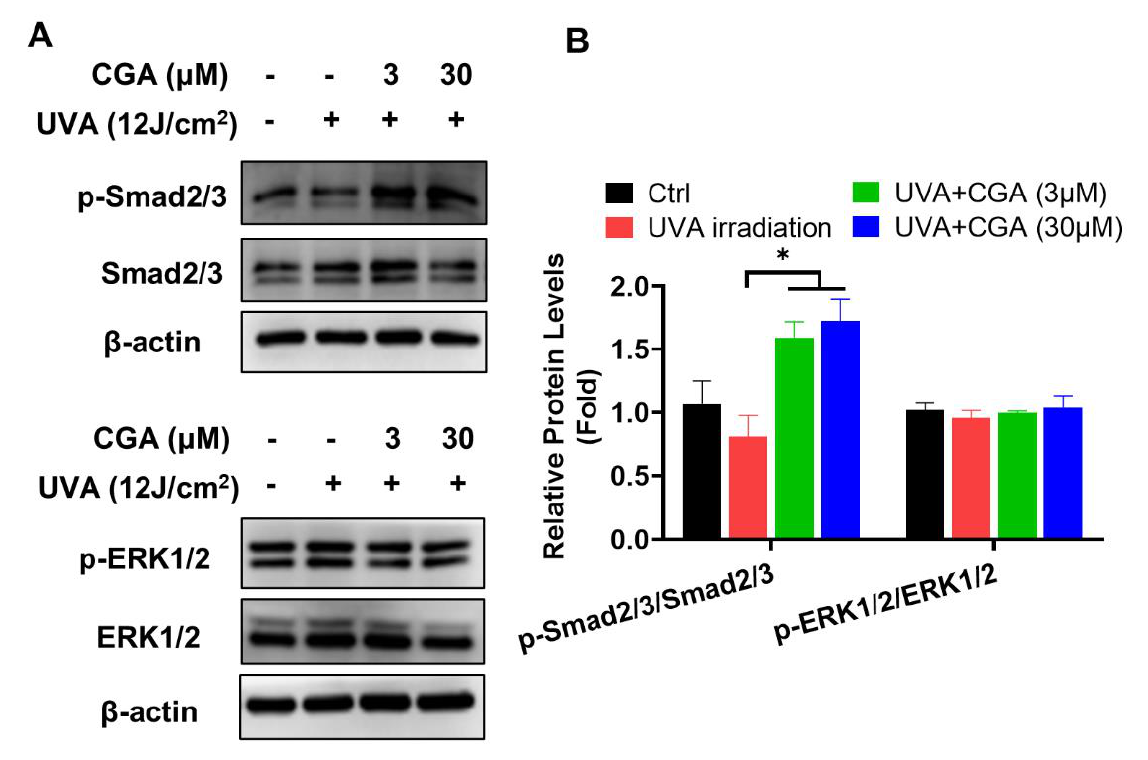
Figure 5. The effect of CGA on Smad2/3 and ERK1/2 signaling pathways in UVA-irradiated HDF- α cells. ( A ) The p-Smad2/3, Smad2/3, p-ERK1/2 and ERK1/2 protein expressions in UVA-irradiated HDF- α cells were measured by western blot assay. ( B ) Relative protein expressions were quantified by densitometry and shown in the histogram. Data are expressed as the mean from three experiments. * p ≤ 0.05 indicate a significant difference.